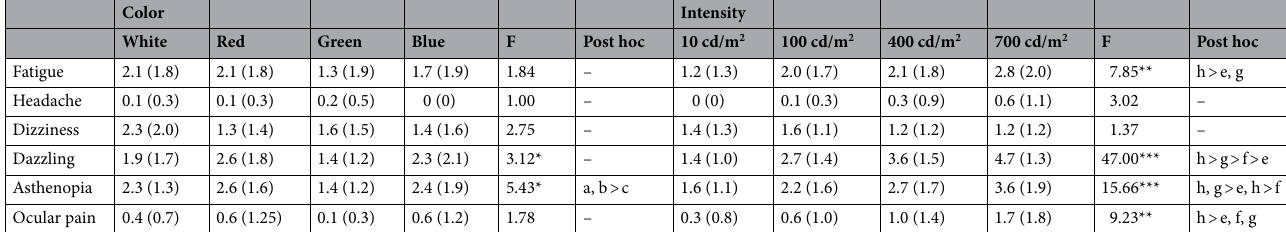
Table 1. Self-reported adverse effects of flickering light stimulation. a, white; b, red; c, green; d, blue; e, 10 cd/ m 2 ; f, 100 cd/m 2 ; g, 400 cd/m 2 ; h, 700 cd/m 2 . * p < 0.05, ** p < 0.01, *** p < 0.001 by repeated measures analysis of